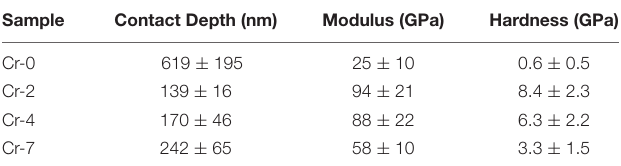
TABLE 5 | Depth of penetration (h), Young’s modulus and hardness measured from the nano-indentation tests on K 2 O-MgO-Al 2 O 3 -B 2 O 3 -SiO 2 -F glasses with and without K 2 Cr 2 O 7